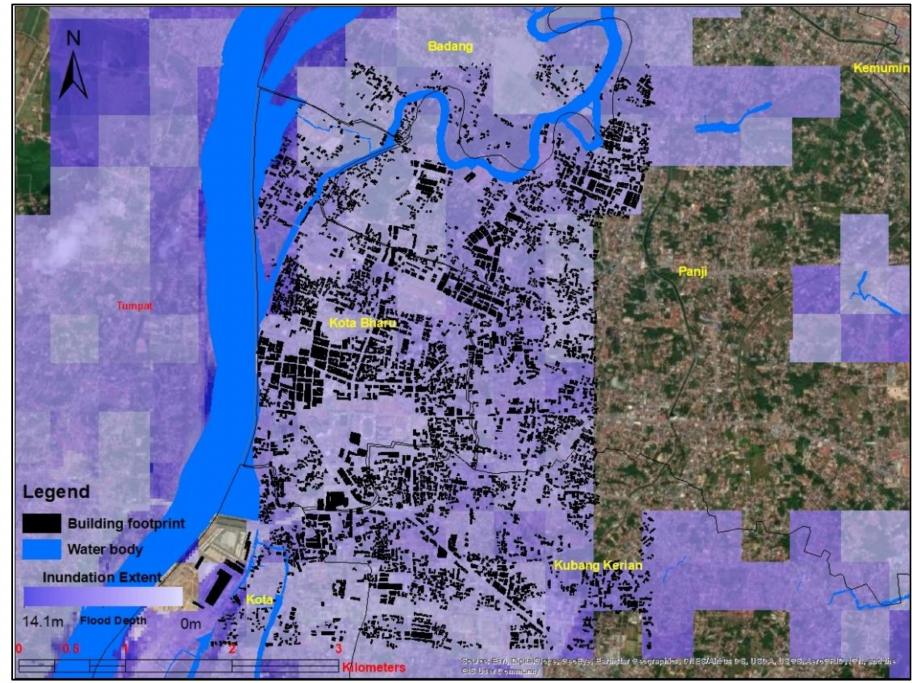
Figure 9. Selecting of inundated buildings by location.